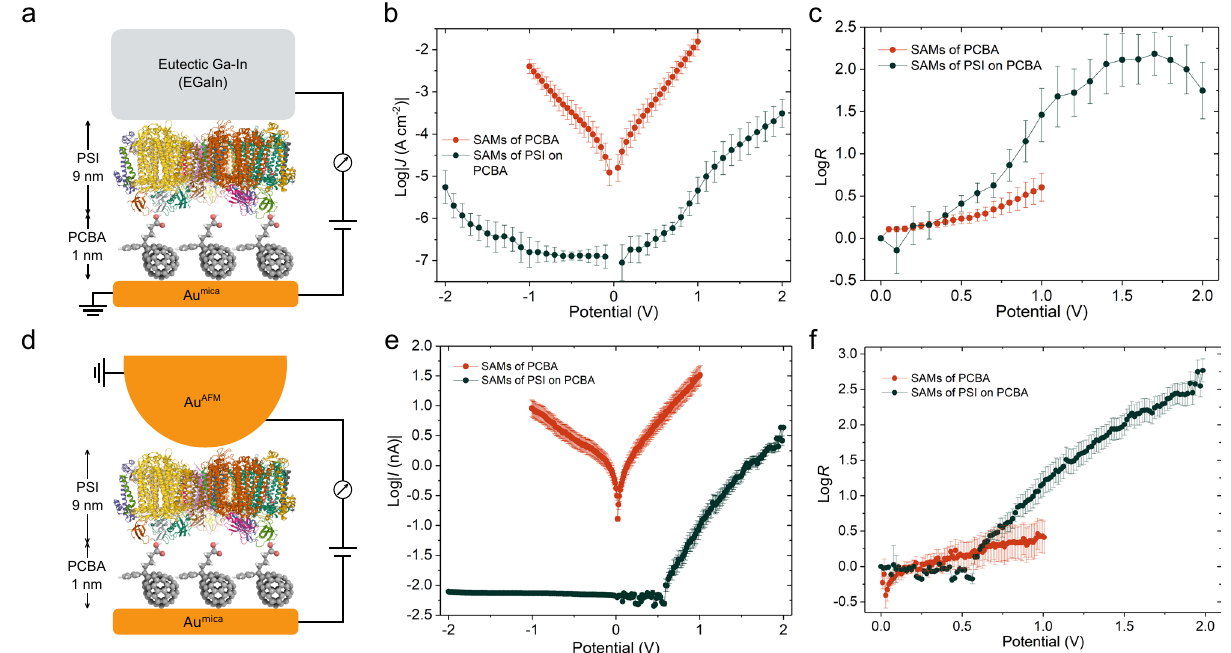
Fig. 1 Characterization of the charge-transport properties of the SAMs of PCBA and the SAMs of PSI on PCBA. a Schematic of the Au mica /PCBA// PSI//EGaIn junctions. b Plots of log| J | versus potential of Au mica /PCBA//EGaIn junctions and Au mica /PCBA//PSI//EGaIn junctions. c Plots of log R versus potential of Au mica /PCBA//EGaIn junctions and Au mica /PCBA//PSI//EGaIn junctions. d Schematic of the Au mica /PCBA//PSI//Au AFM junctions. e Plots of log| I | versus potential of Au mica /PCBA//Au AFM junctions and Au mica /PCBA//PSI//Au AFM junctions. f Plots of log R versus potential of Au mica /PCBA// Au AFM junctions and Au mica /PCBA//PSI//Au AFM junctions. Error bars represent 95% con fi dence intervals. Drawings of molecules do not correspond to their actual